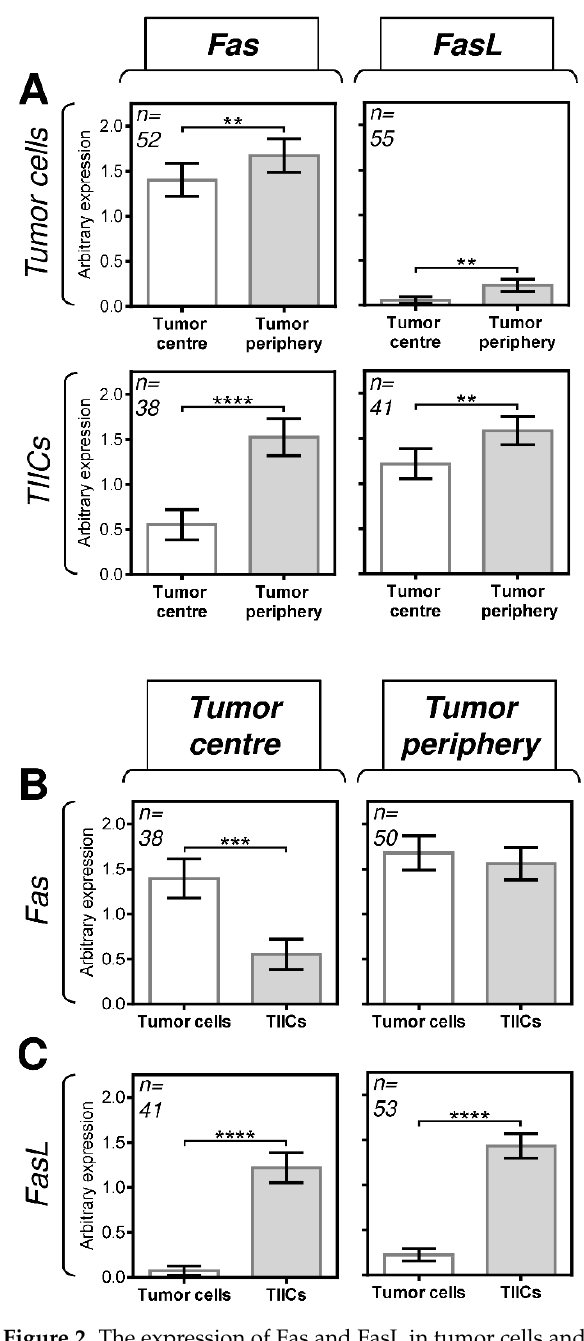
Figure 2. The expression of Fas and FasL in tumor cells and TIICs in the tumor periphery and center. ( A ) The expression (tumor proportion score (TPS)) of Fas and FasL in tumor cells and TIICs is higher in the tumor periphery than in the tumor center. The number of patients ( n ) evaluated is shown in the top left corner of each panel. ( B ) The expression of Fas in tumor cells is higher than that in TIICs in the tumor center but comparable to that in the tumor periphery. ( C ) The expression of FasL in tumor cells is lower than that in TIICs in both the tumor center and tumor periphery. In A – C , the expression analyses were performed according to the TPS scoring system described in the Materials and Methods section. The data are presented as the mean ± SEM of the TPS score calculated from the TPS scores of individual patients’ samples. The number of patients ( n ) evaluated is shown in the top left corner of each panel. The difference between groups was evaluated by the Mann–Whitney U test ( n is shown in the top left corner of each panel, ** p < 0.01, *** p < 0.001, and **** p < 0.0001).